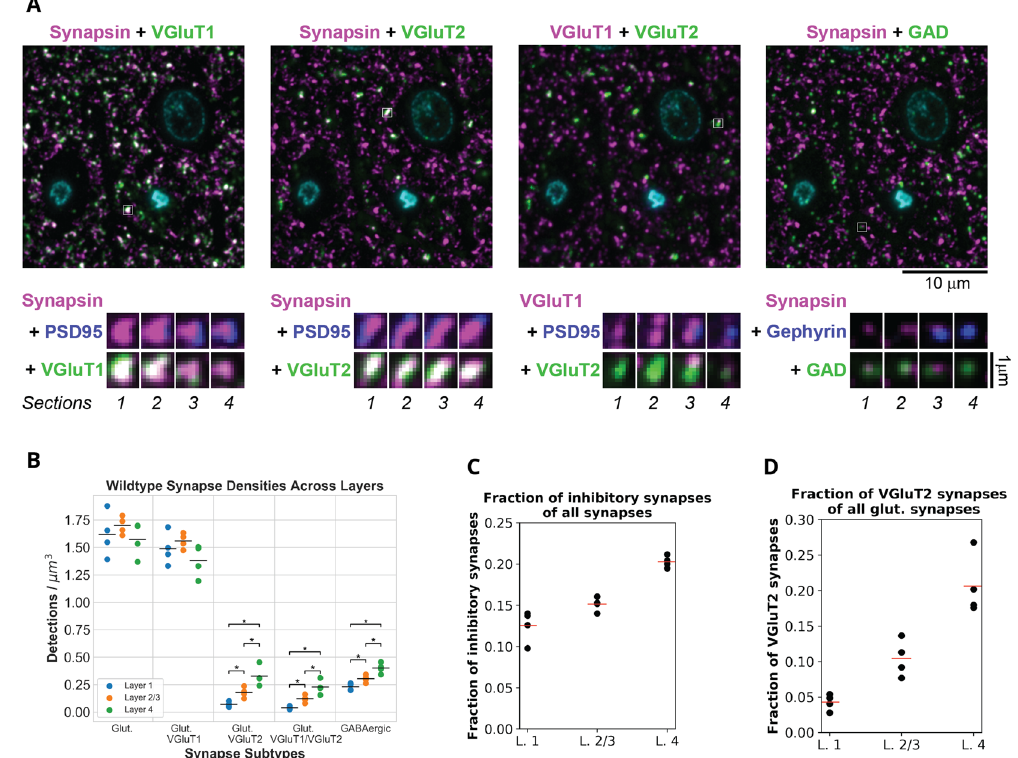
Figure 4. Overview of wild-type synapse density distributions. ( A ) Top, multiplexed immunofluorescence from the same area of a single section of the somatosensory cortex of a WT mouse. The nuclear stain DAPI is in cyan. White squares highlight individual synapses, which in A, bottom, are shown at higher magnification on 4 consecutive serial sections. ( B ) The distribution of synapse types across different layers. Layers with significant differences for a synapse type are marked. While there is no significant difference in layer densities for glutamatergic synapses overall and for glutamatergic synapses with VGluT1, there is a significant difference between layers for glutamatergic synapses with VGluT2, with both VGluT1 and VGluT2, and for inhibitory synapses. ( C ) Fraction of inhibitory synapses in layers 1 through 4 of mouse somatosensory cortex. ( D ) Fraction of VGluT2 synapses in layers 1 through 4 of the mouse somatosensory cortex.